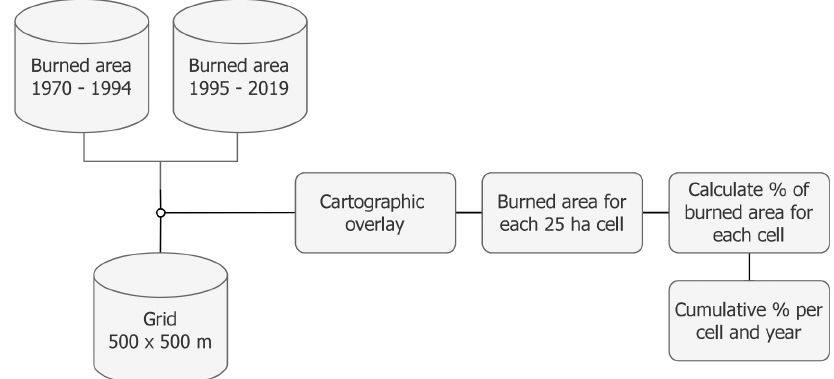
Figure 4. Flowchart depicting the processing steps for generating the cumulative percentage of forested burned area per cell.